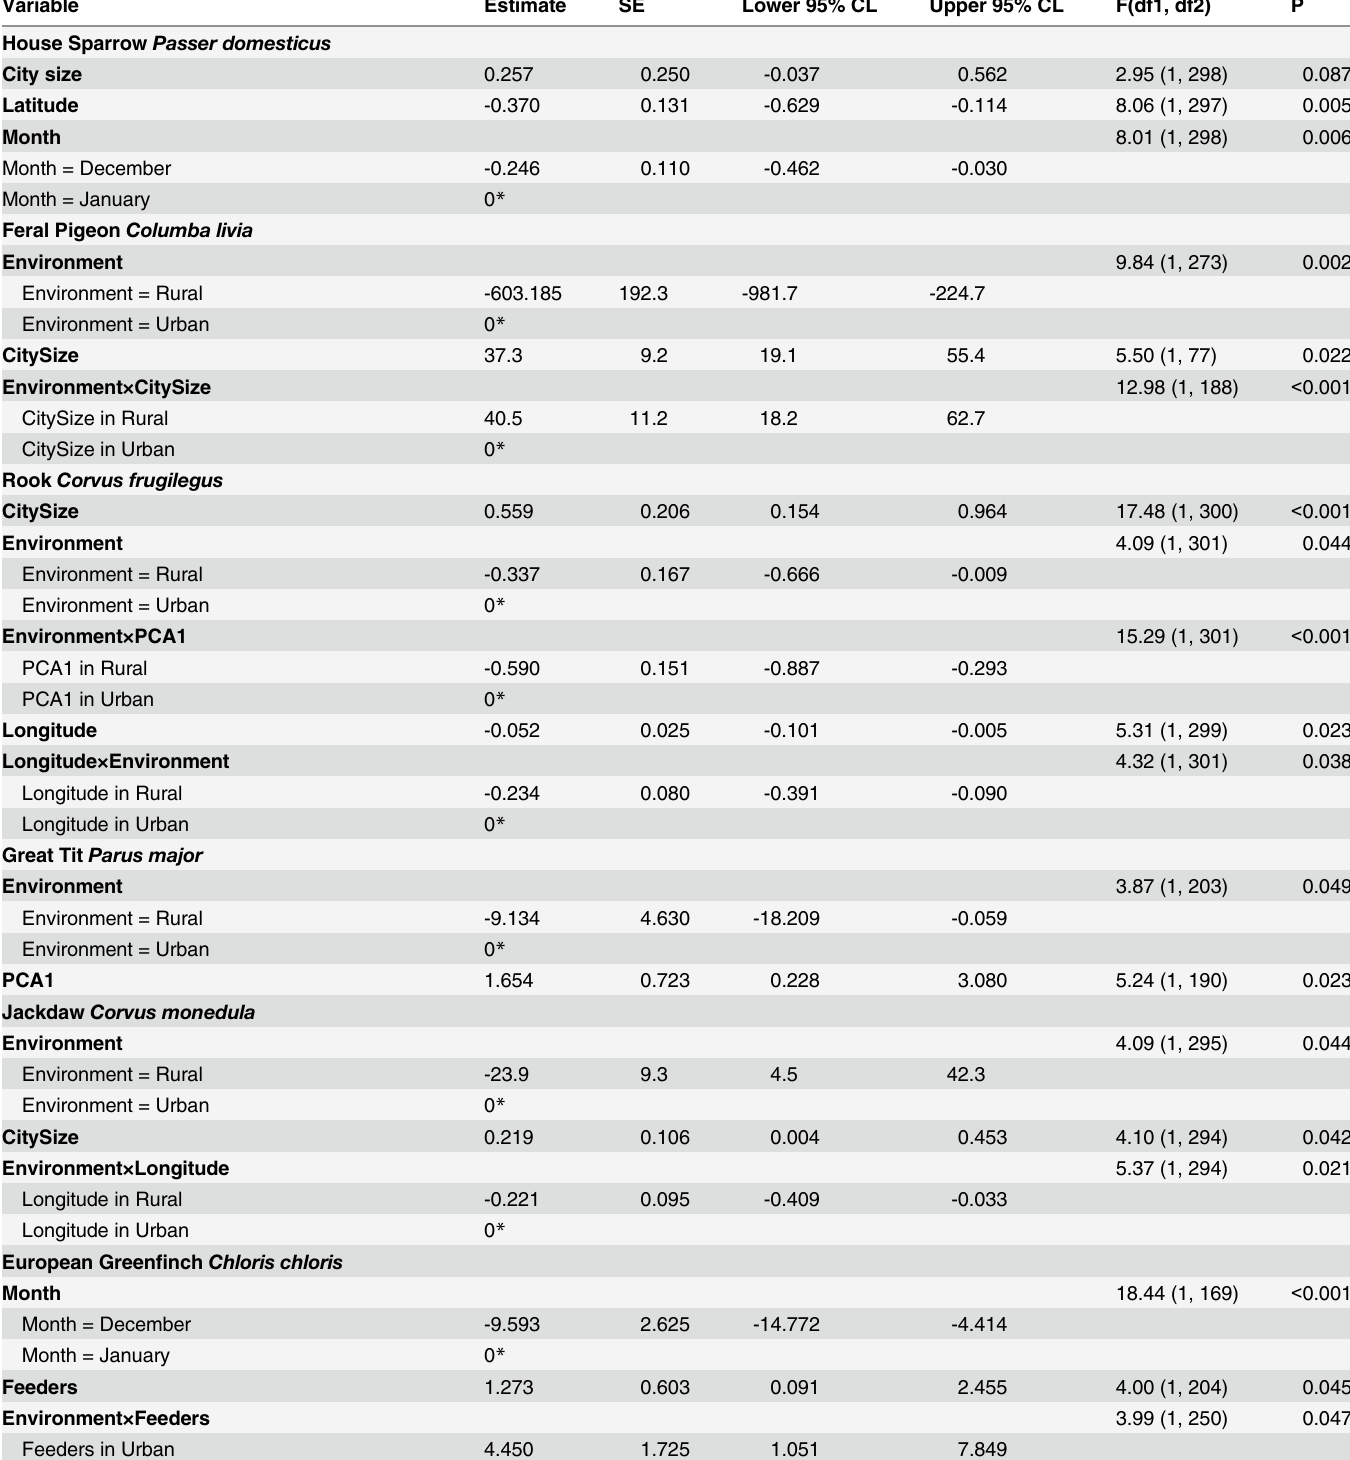
Table 6. Averaged estimates of the function slopes of variables present in the most parsimonious GLMMs describing the corrected abundance of the 10 most numerous recorded bird